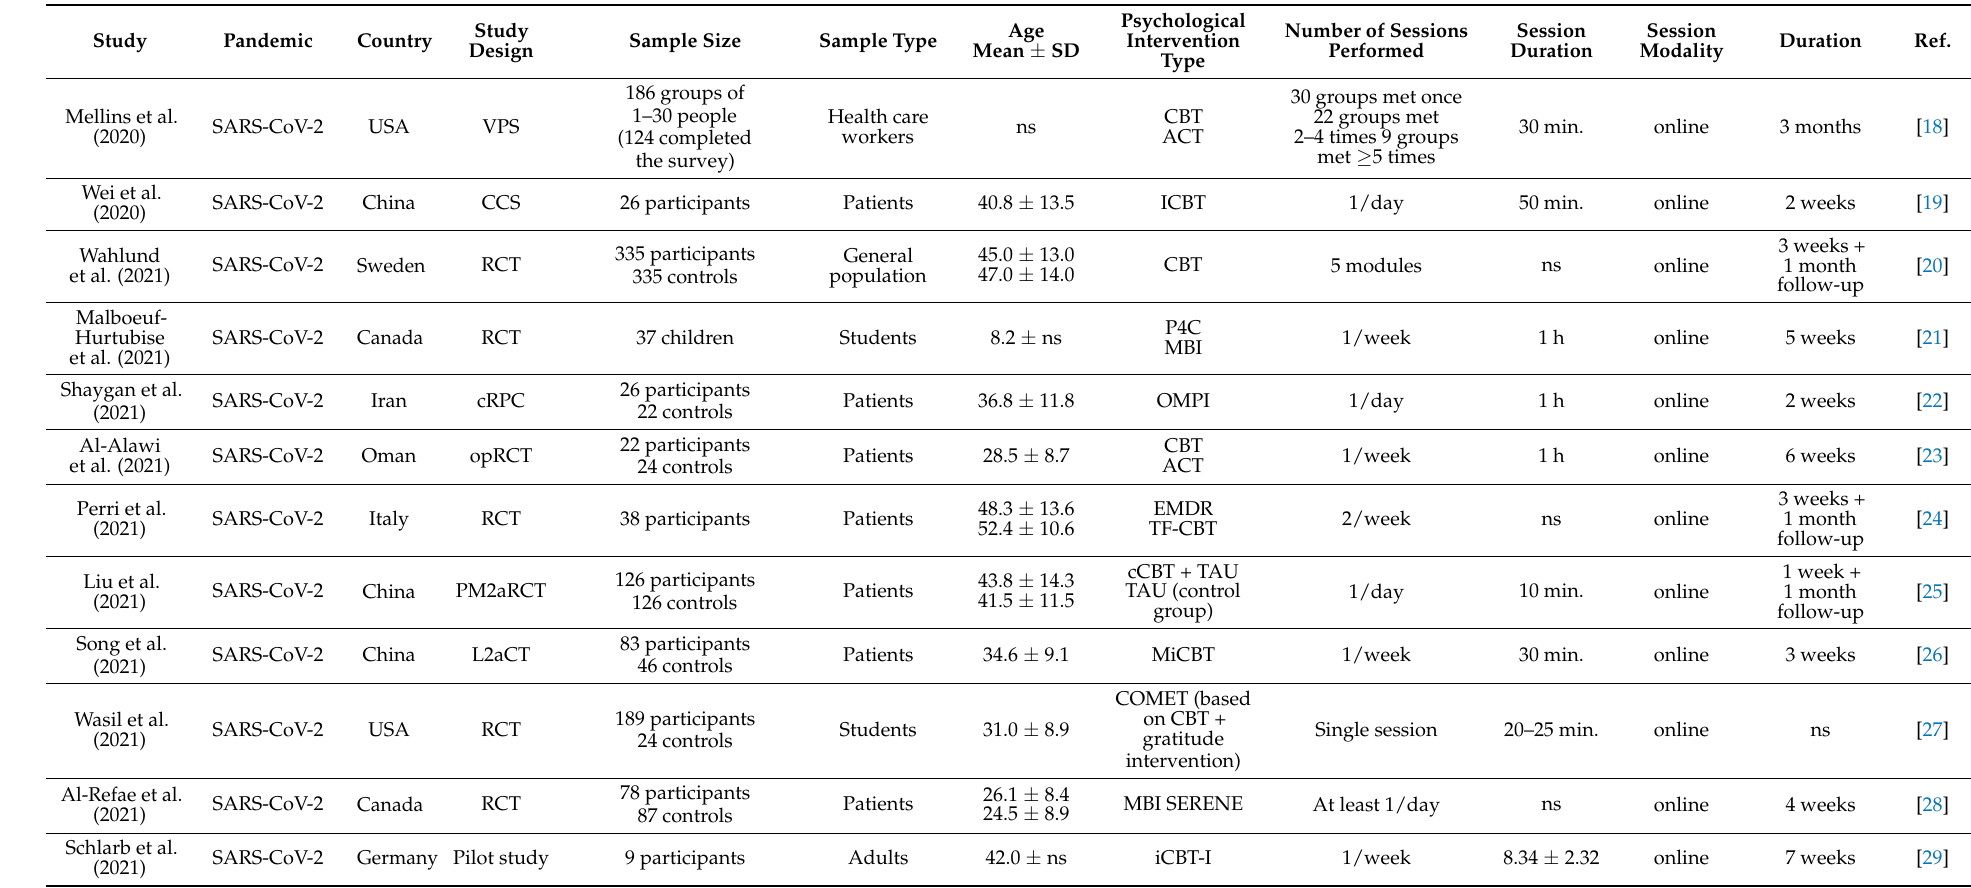
Table 1. A general overview of the included